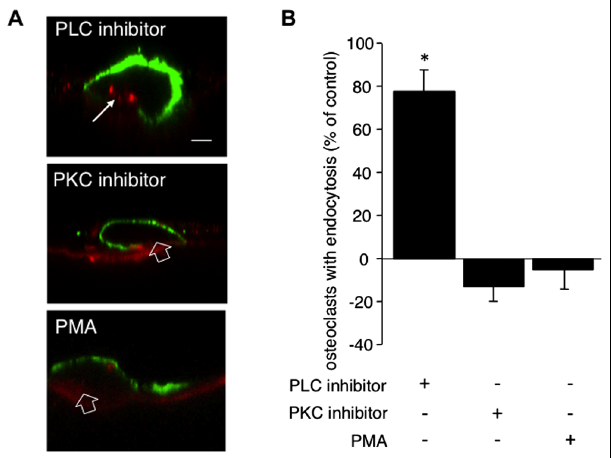
FIGURE 2 | PLC but not PKC signaling conveys the inhibitory effect of calcitonin on endocytosis. Osteoclasts plated on dentine for 16 h were pre-incubated for 5 min with either the PLC inhibitor U-73122 (1 μ M) or the PKC inhibitor bisindolylmaleimide (1 μ M) or the PKC activator PMA (1 μ M) before the addition of calcitonin for 30 min.TRITC-dextran 3,000 was then added for 5 min before fixation. Cells were immunodecorated with antibodies directed against α v β 3 integrin. (A) Representative lateral view of treated cells. Red,TRITC-dextran; arrow, endocytosedTRITC-dextran; open arrow, ruffled border area without endocytosis; green, anti- α v β 3 antibodies. Scale bar: 10 μ m.Treatment with the PLC inhibitor restores endocytic trafficking whereas neither the PKC inhibitor nor the PKC activator PMA has an effect. (B) The number of osteoclasts displaying endocytosed dextran was counted and expressed as percentage of total. Columns show mean percentage of osteoclasts with dextran endocytosis compared to calcitonin treatment alone (set to 0). Results are average of three independent experiments. Error bars show standard deviation and significant increases in endocytosis-active osteoclasts are marked: * p < 0.05.Treatment with the PLC inhibitor restores endocytic trafficking to 77% whereas